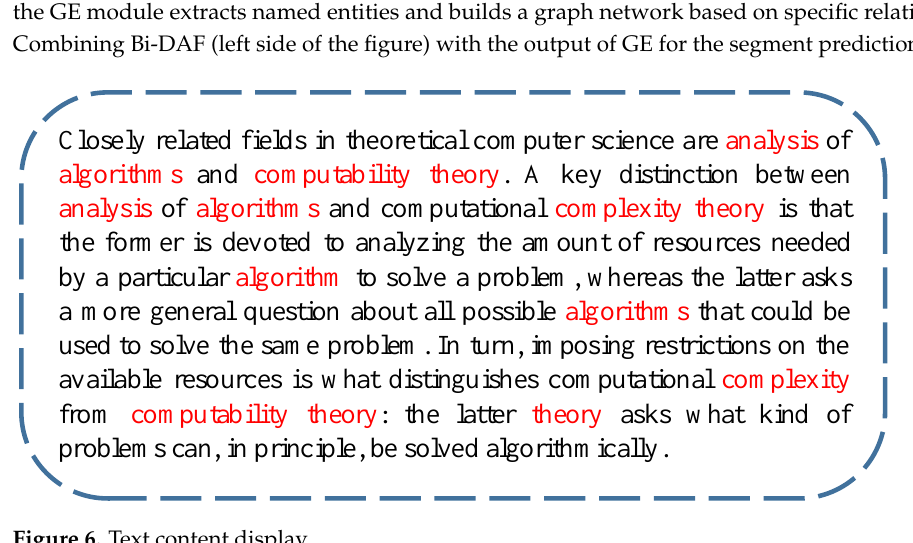
Figure 6. Text content